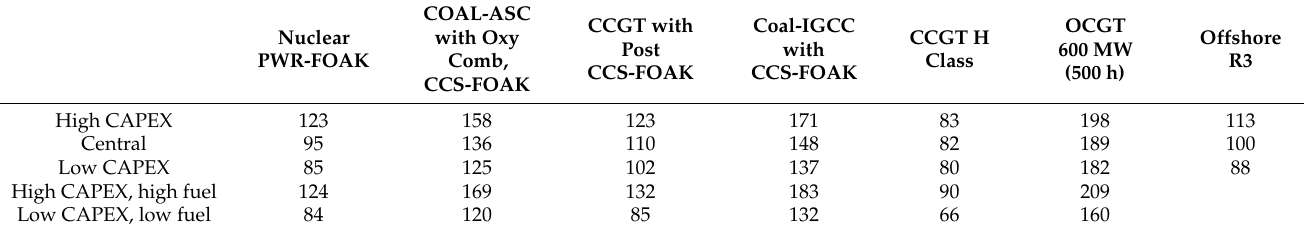
Table 4. Government LCOE Valuations.